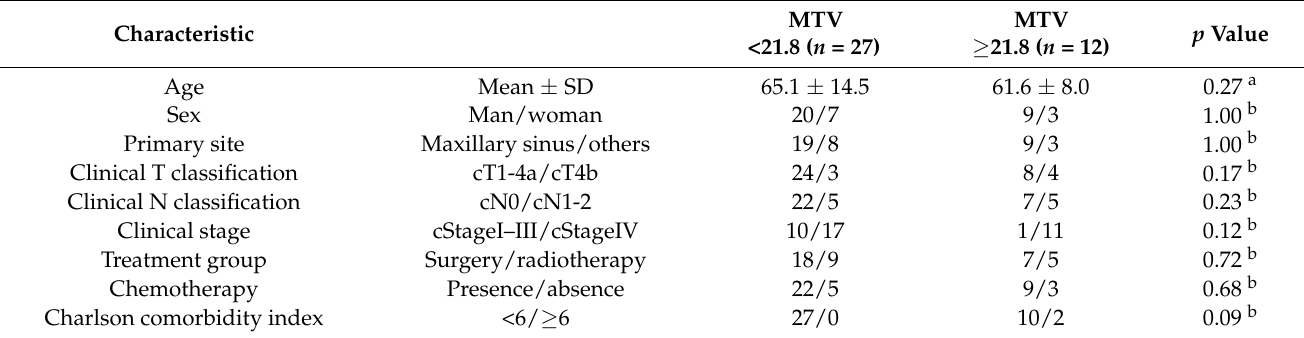
Table 3. Multivariable survival analysis in sinonasal tract SCC by Cox’s proportional hazards model.